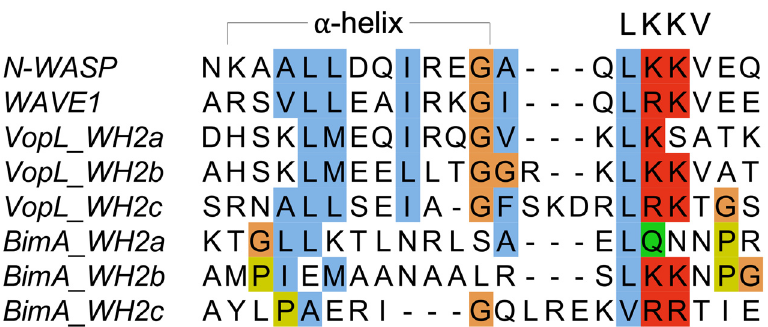
Figure 3. Sequence alignment of putative WH2 motifs in Burkholderia BimA and Vibrio VopL. The sequences of the known WH2 motifs of human N-WASP (Uniprot O00401) amino acids 405–424 and human WAVE1 (Uniprot Q92558) amino acids 497–516 are displayed for reference. The positions of the ⍺ -helix and LKKV are shown above. Amino acid numbering for the displayed sequences is as